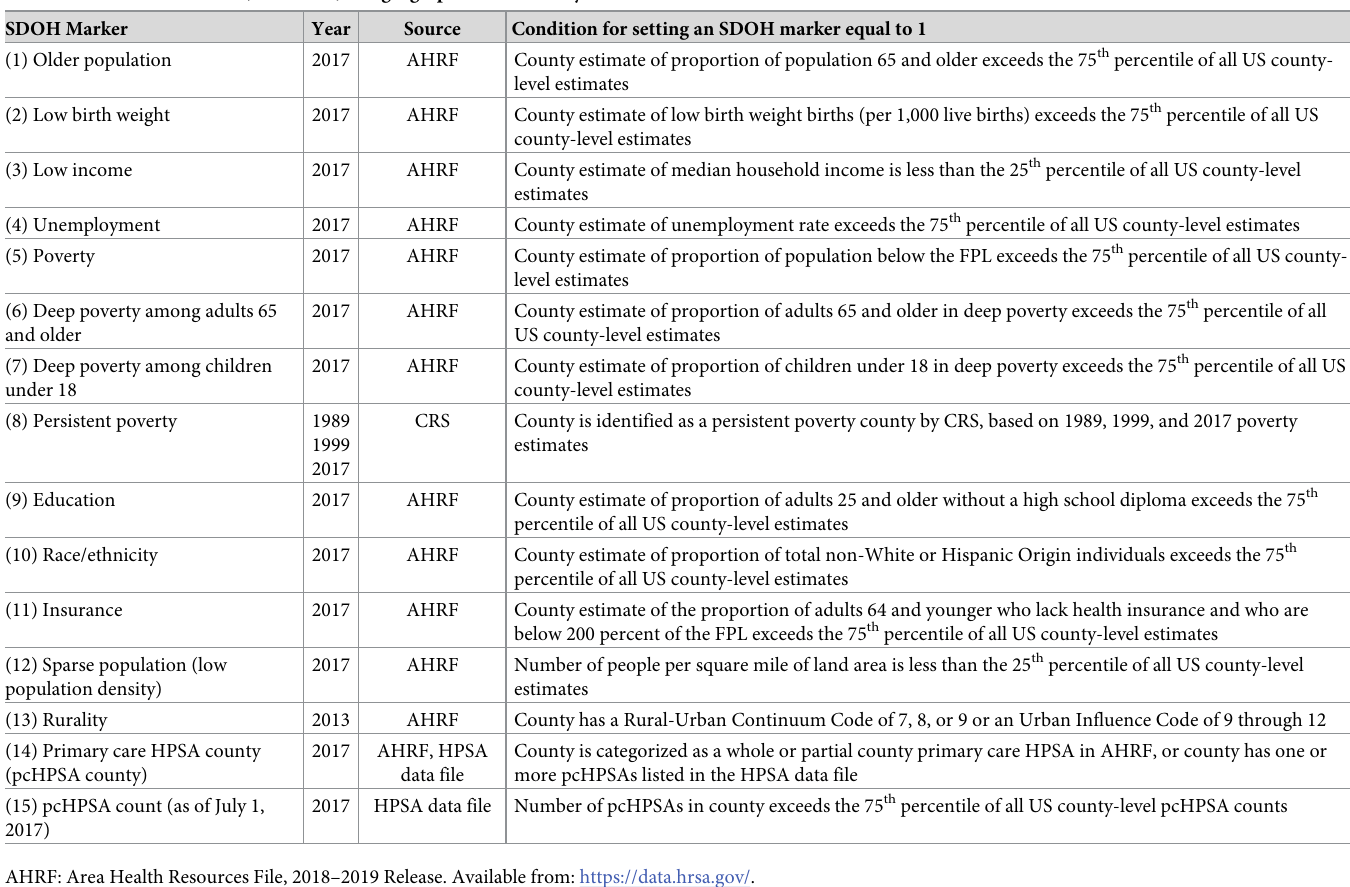
Table 1. Markers for medical, economic, and geographic vulnerability. SDOH